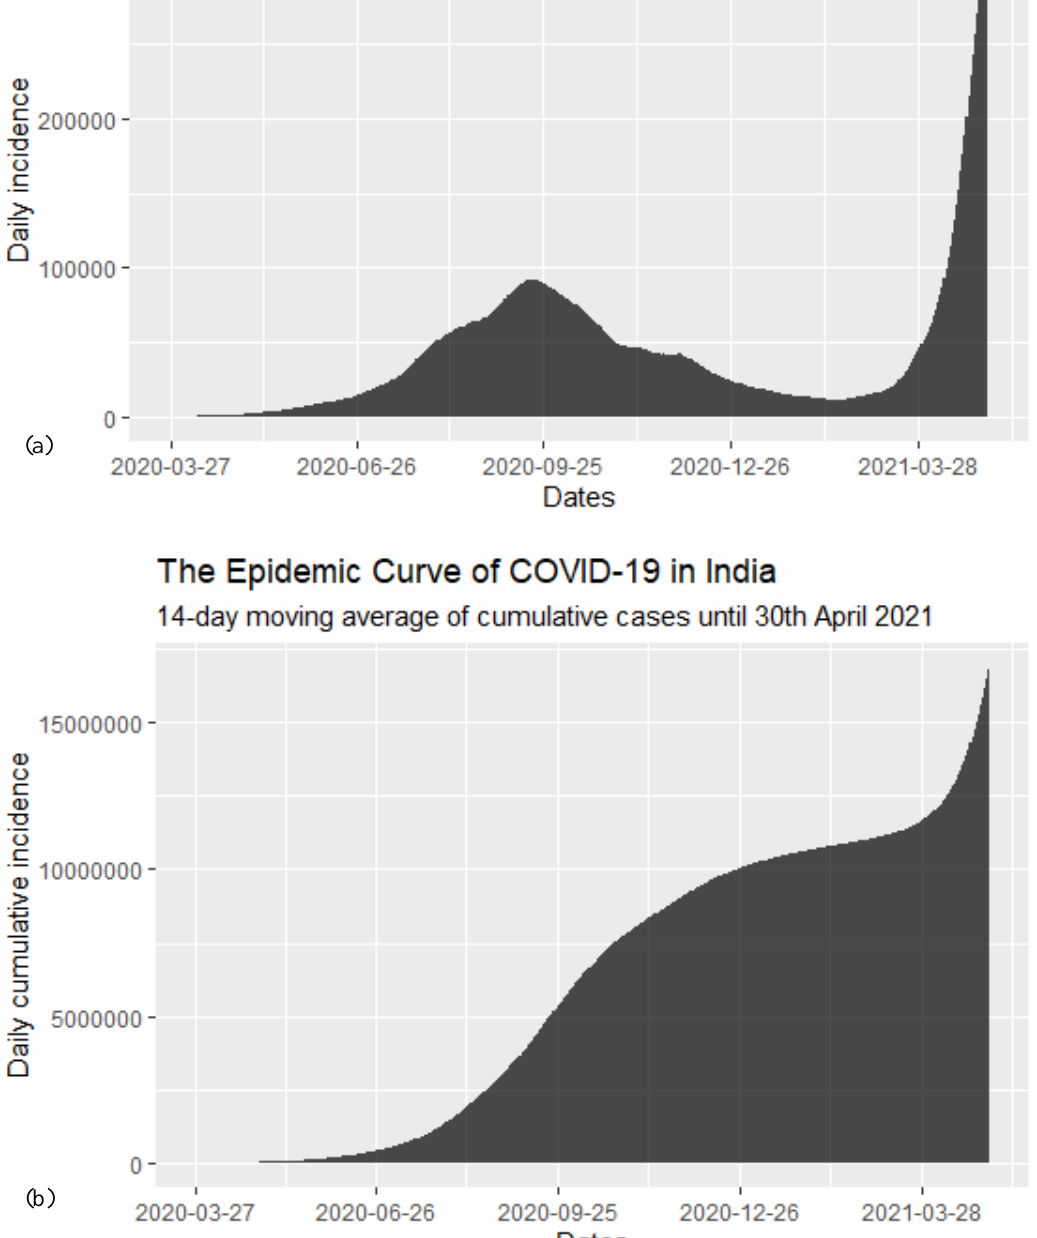
Figure 1. (a) The epidemic curve of daily new COVID-19 cases in India; (b) Cumulative incidence of COVID-19 in